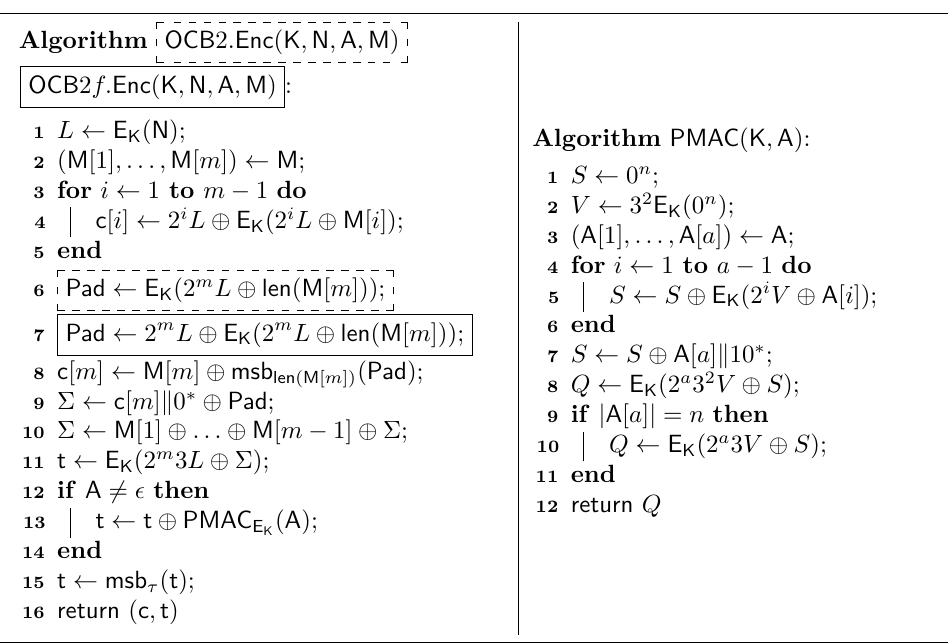
Figure 3: OCB2 and OCB2f block-cipher modes. The encryption algorithms of both schemes only differ in the way “ Pad ” values are defined: Line 6 (dashed box) in OCB2 and Line 7 (normal box) in